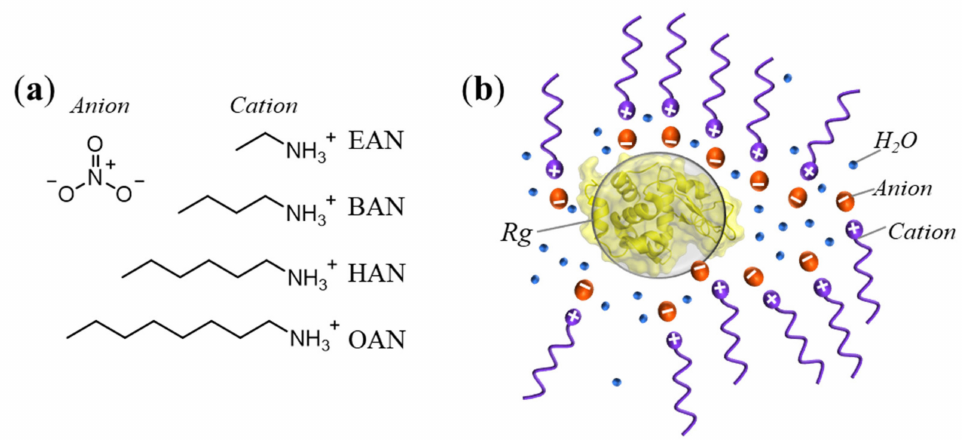
Figure 1. ( a ) Chemical structures of the four chosen PILs for this study, and ( b ) the schematic of lysozyme in the presence of nanostructured HAN as an example. The PILs include ethylammonium nitrate (EAN), butylammonium nitrate (BAN), hexylammonium nitrate (HAN), and octylammonium nitrate (OAN). The correlation distance d of HAN and radius of gyration R g lysozyme were obtained from SAXS experiments, while d refers to the average repeat distance of the head groups of PILs separated by their alkyl